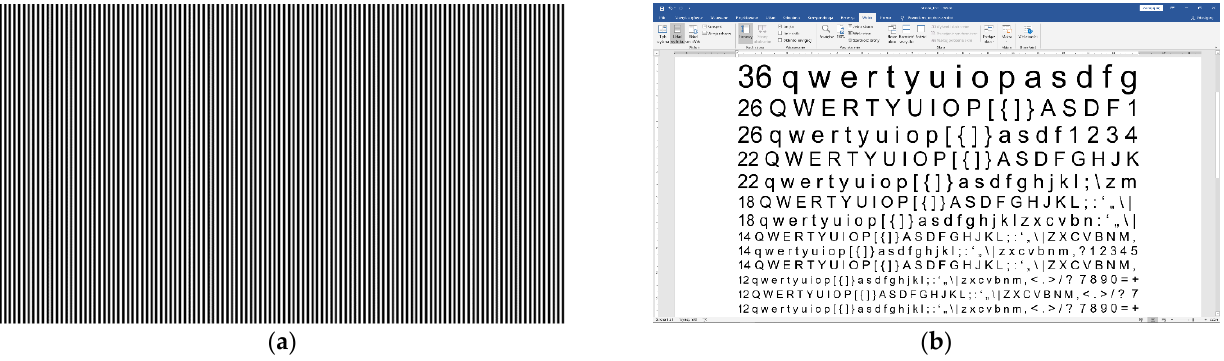
Figure 2. Test images: ( a ) 8 × 8 vertical stripes and ( b ) a window of MS Word editor. The images sizes correspond to a screen resolution of 1920 × 1080 pixels. Based on the information contained in [7], models of video signals corresponding to the vertical refresh rate of 60 Hz were created. Under these conditions, the horizontal frequency is 67.5 kHz and the pixel frequency is 148.5 MHz. In order to map the characteristics of the real propagation channel (radiated type) of the reveal signals, the obtained signal was subjected to the differentiation operation. The amplitude spectra of the above-mentioned